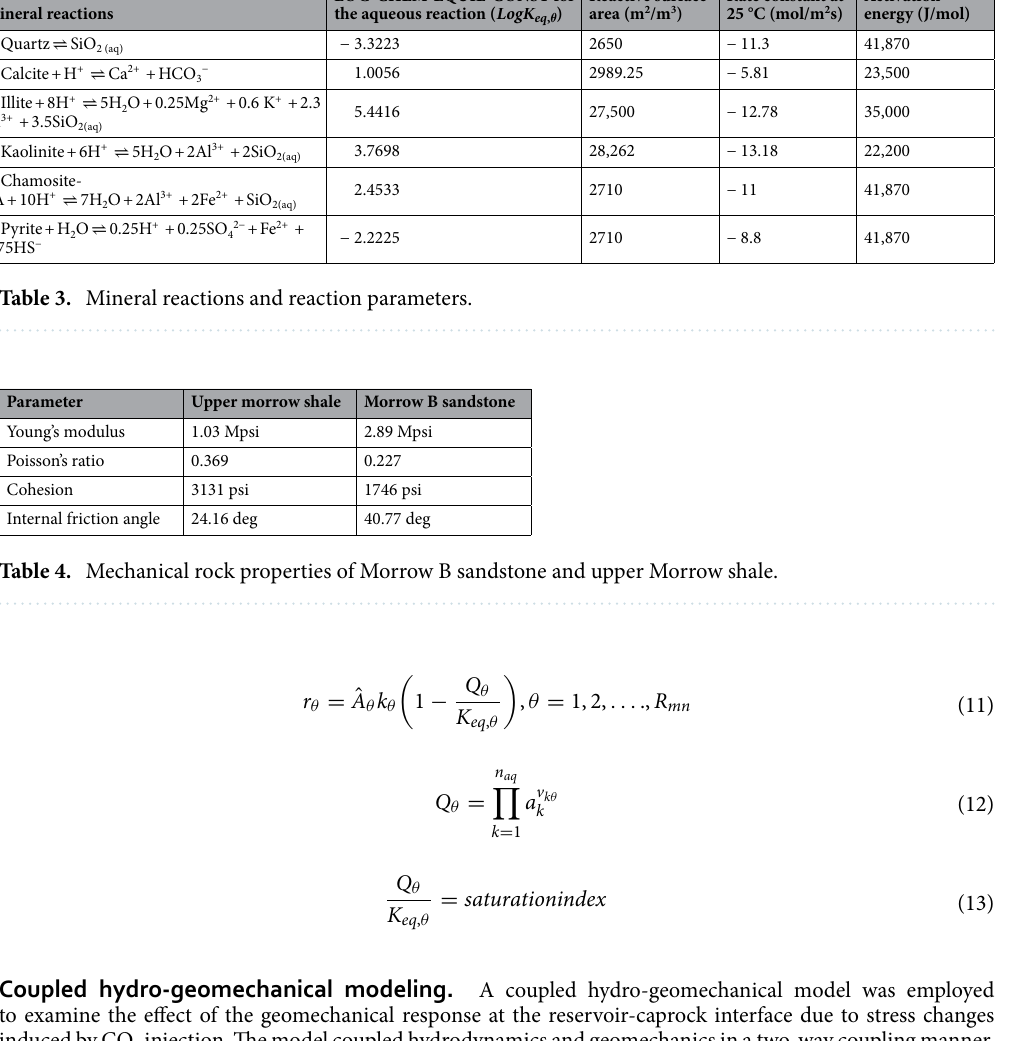
Mineral reactions